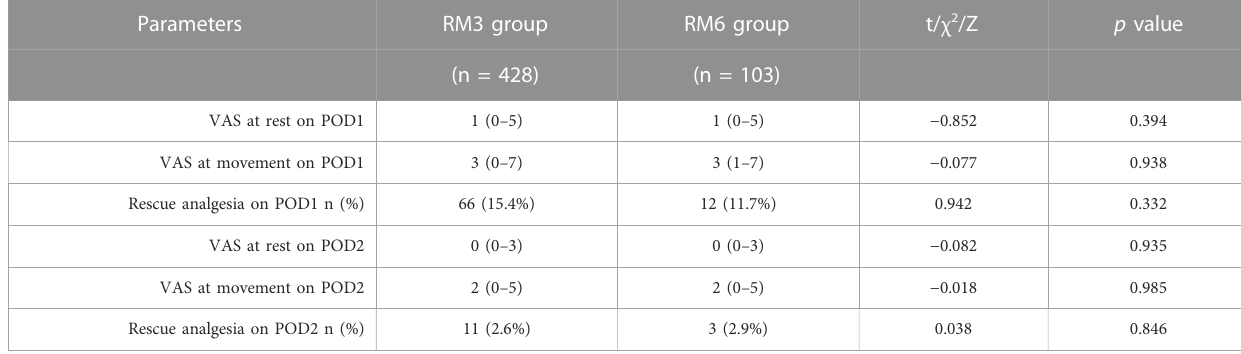
TABLE 2 Analgesic ef fi cacy and rescue analgesia in RM3 and RM6 groups.